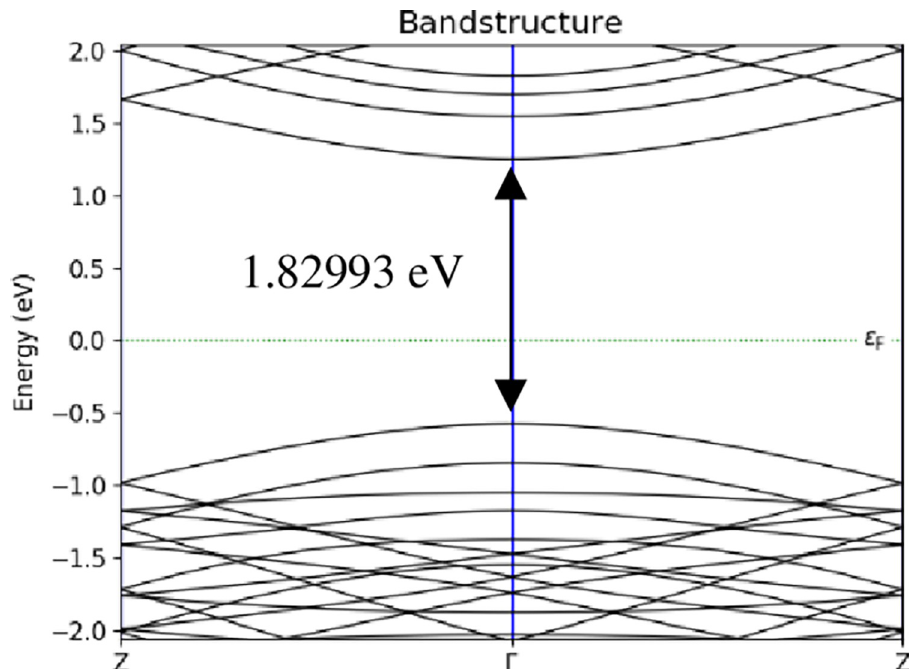
Fig 9. Energy band structures of 12-BC 2 NNR with different positions of H 2 gas molecules at boron atom for T = 298 K .